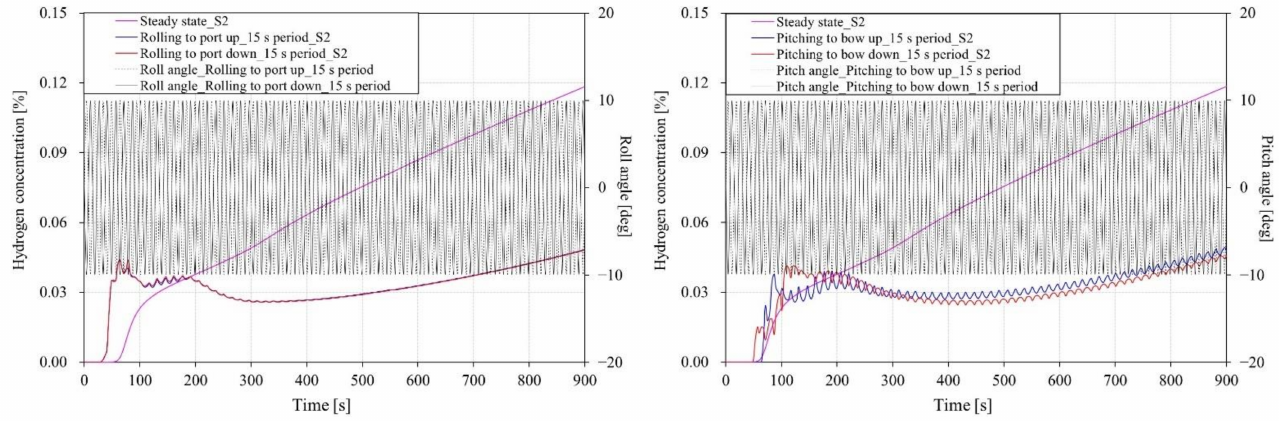
Figure 13. Hydrogen concentration by roll and pitch motion at